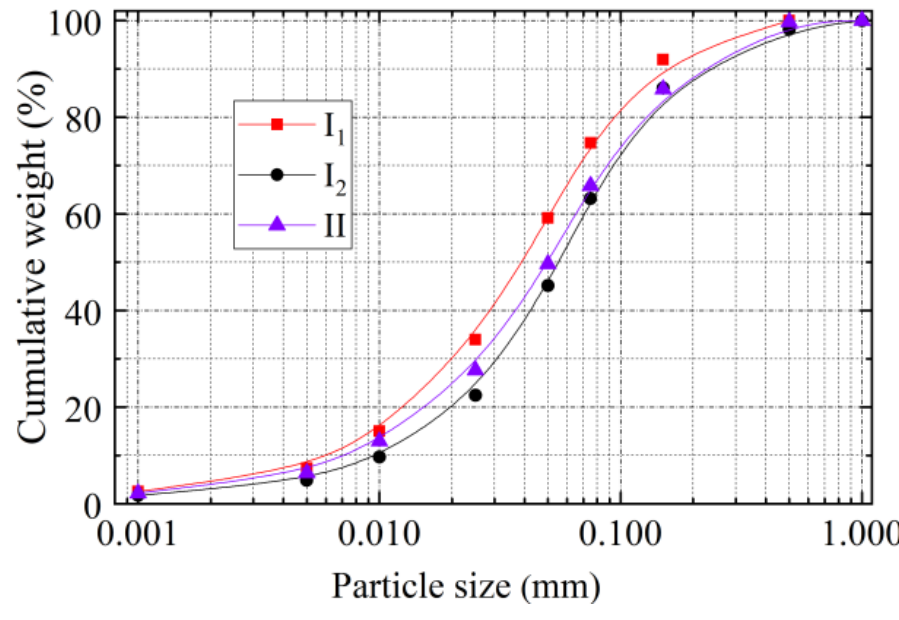
Figure 6. Fine particle grading curve of soil sample.